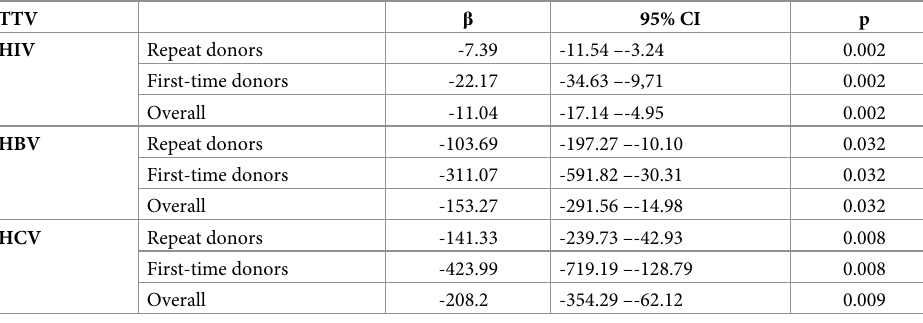
Table 4. Trends of HBV, HCV and HIV transmission residual